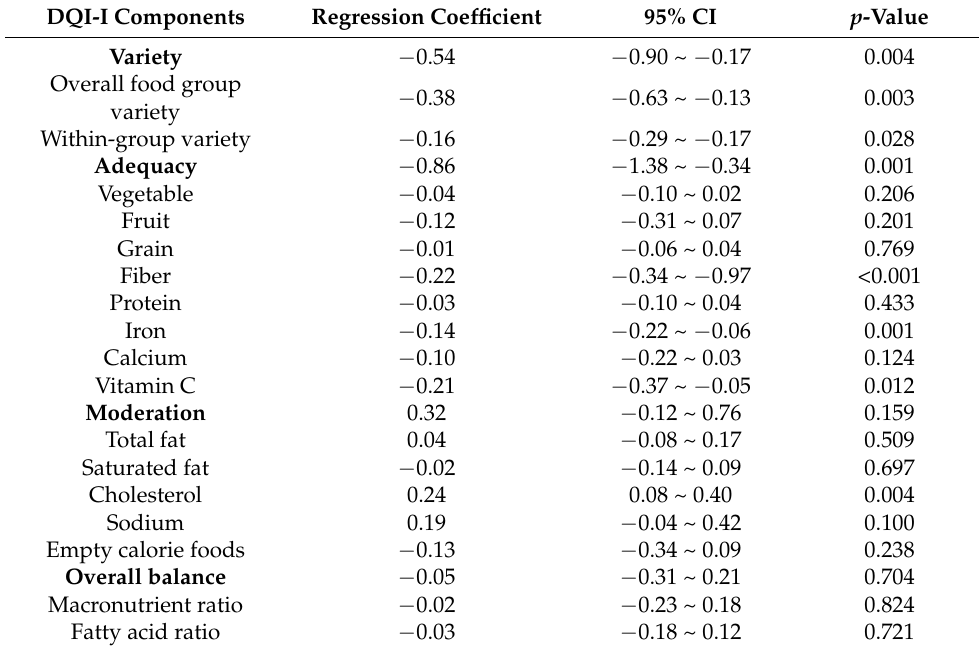
Table 3. Multivariate analysis for DQI-I components associated with